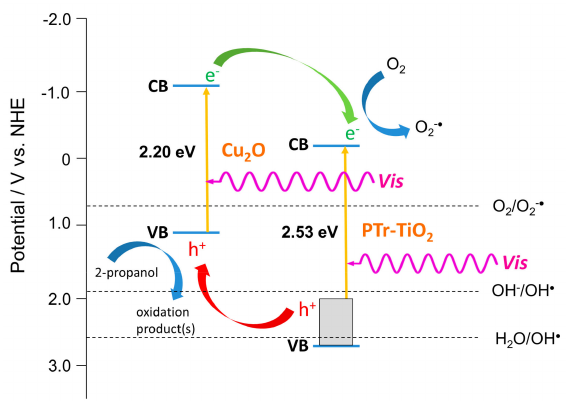
Figure 8. Energy diagram for the Cu 2 O/PTr–TiO 2 photocatalytic system working under visible light, illustrating the coupling of two semiconductors as a type II heterojunction.